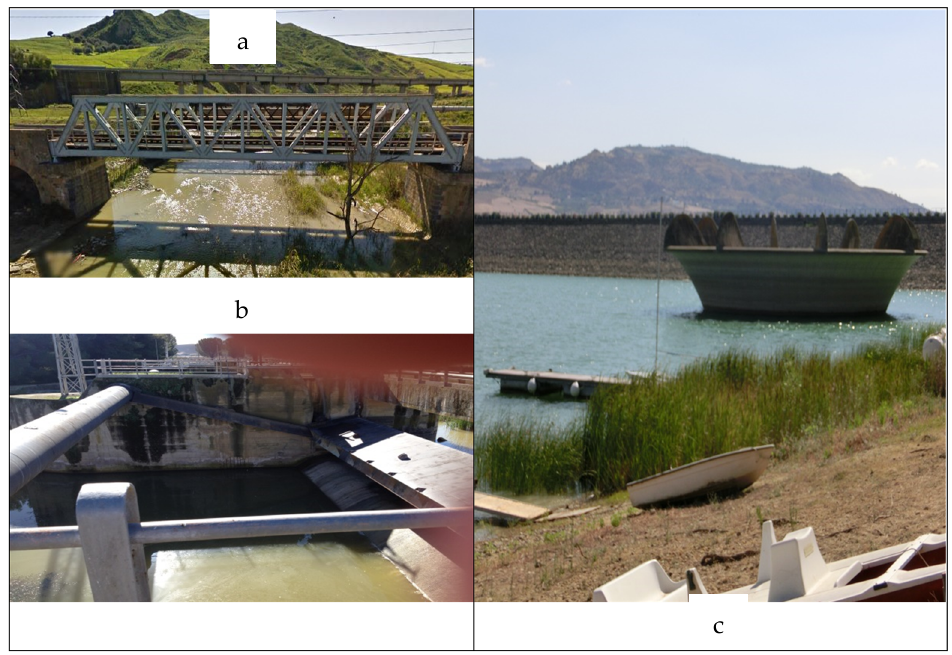
Figure 4. The study area. ( a ) Dittaino River; ( b ) abstraction weirs; ( c ) Nicoletti dam.